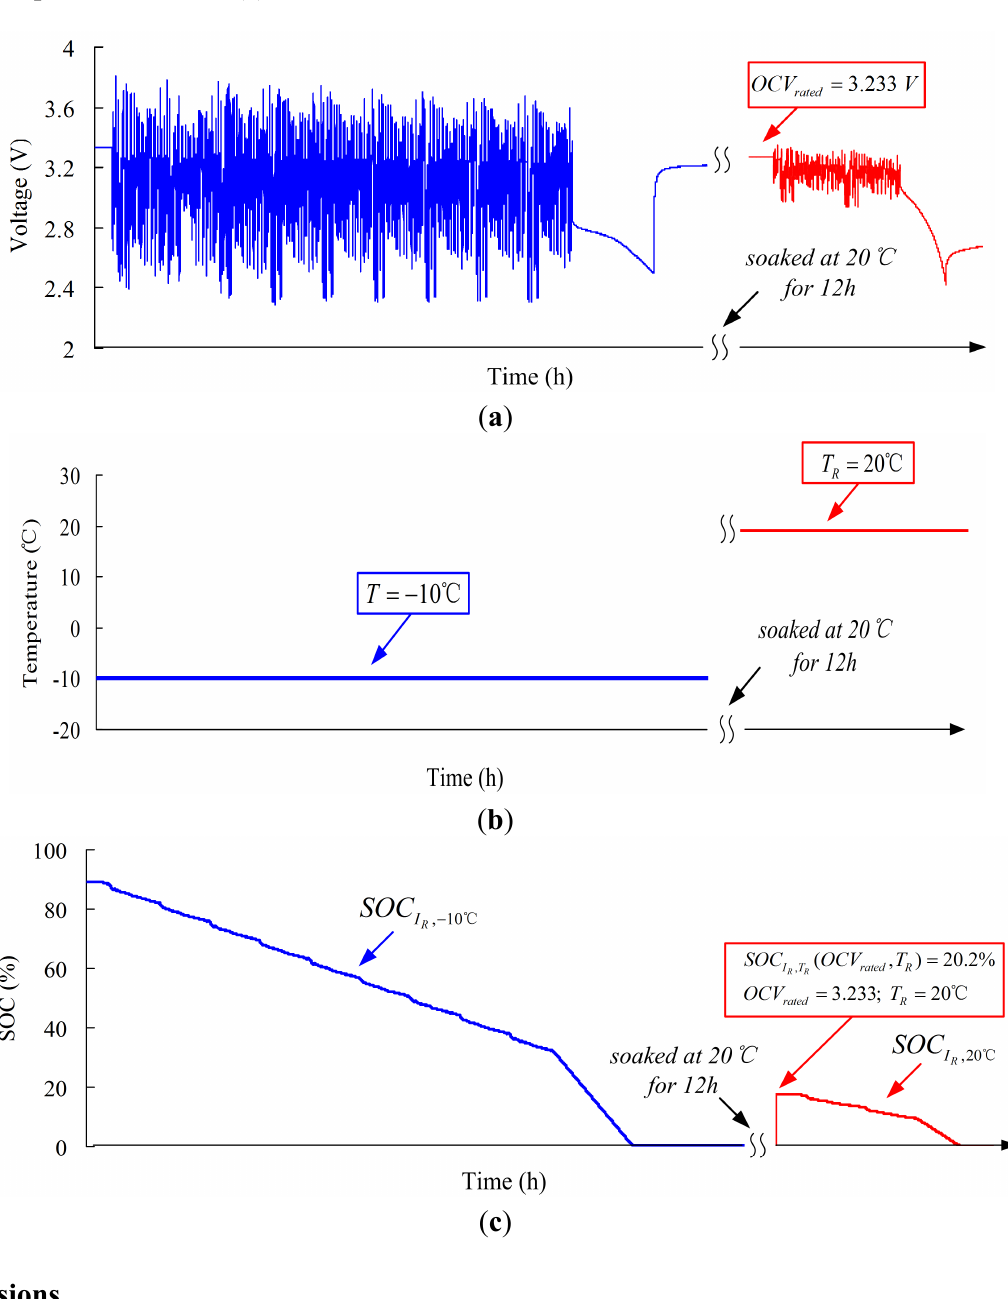
Figure 20. FUDS cycle test during alternated temperature. ( a ) Voltage curves; ( b ) temperature curves; ( c ) SOC